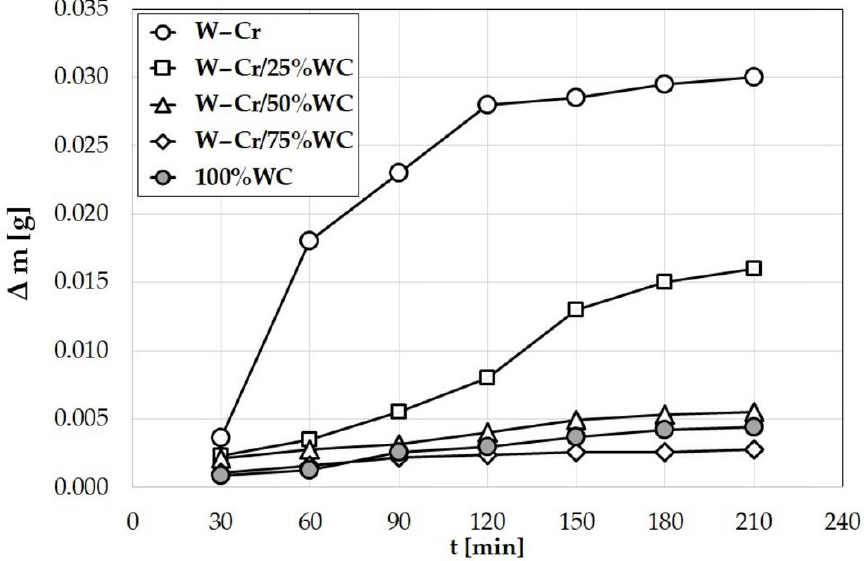
Figure 15. Wear resistance of produced W–Cr metal matrix composite coatings reinforced with WC WC particles .